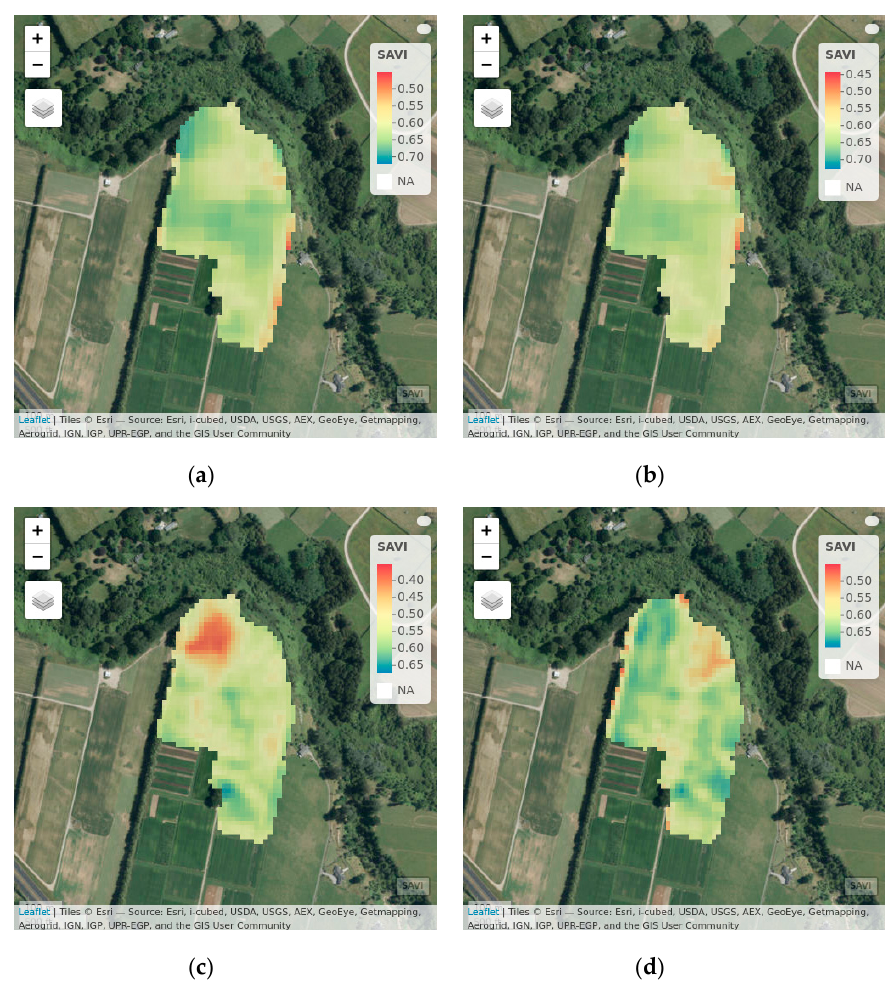
Figure 4. SAVI images captured in February (site 1): ( a ) SAVI image (9 February 2014); ( b ) SAVI image (12 February 2015); ( c ) SAVI image (23 February 2017); ( d ) SAVI image (23 February 2018). SAVI values typically range from 0 to 1. A higher SAVI indicates better plant health and larger biomass.